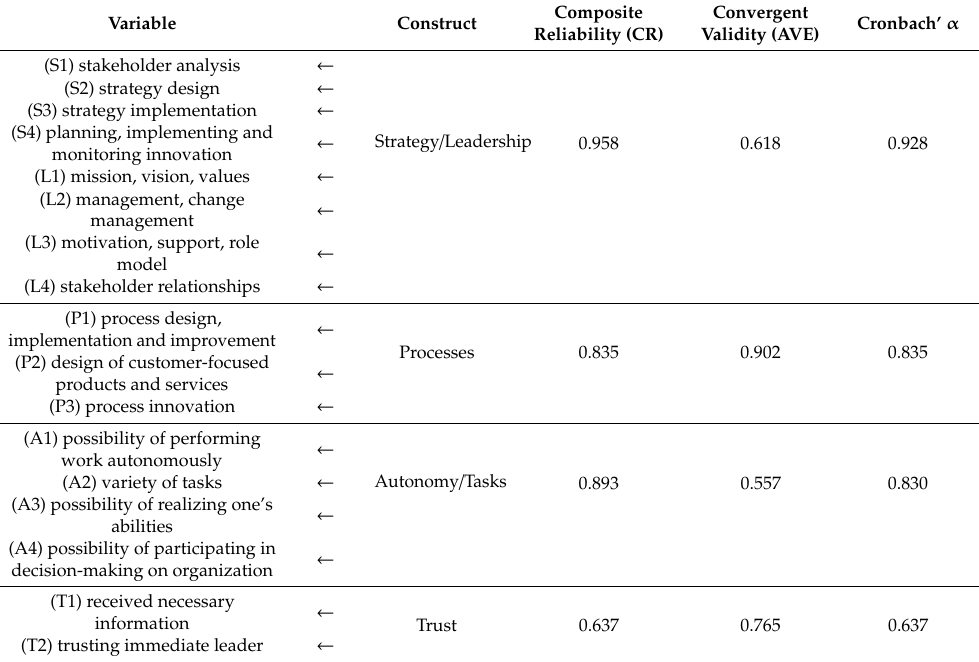
Table 3. Validity and reliability indicators.